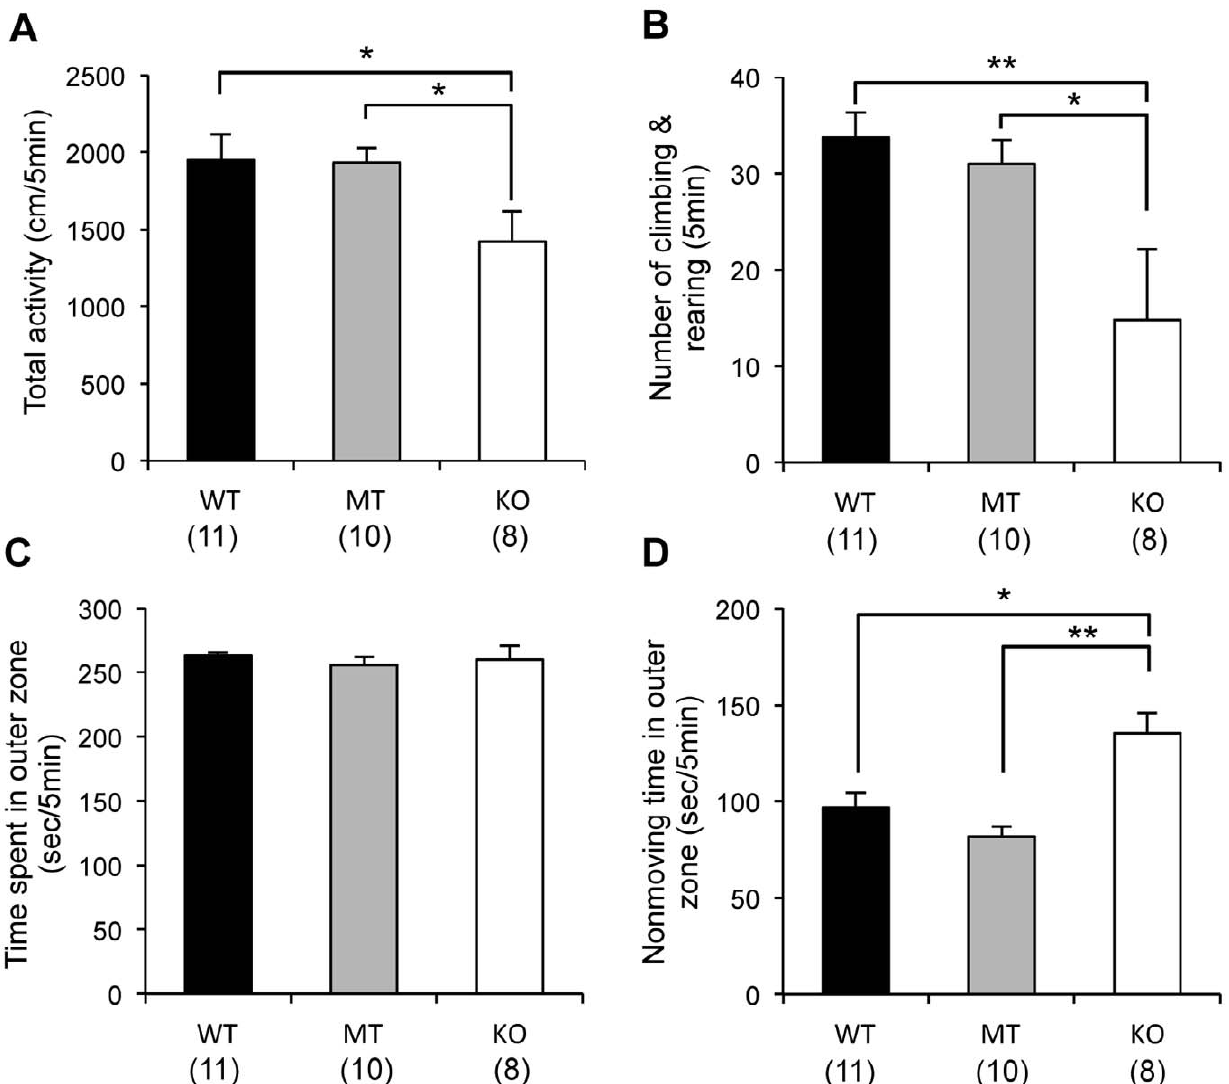
Figure 1. Open field test. Total distance of movement (A), number of climbing and rearing events (B), time spent in the outer zone (C), and resting time in the outer zone (D) of an open field for 5 min. Usp46 KO mice showed significantly lower values than WT and MT mice for the total distance of movement and the number of climbing and rearing events. Nonmoving time in the outer zone was significantly higher for KO mice. The number of mice used is shown within parentheses. One-way ANOVA with Fisher’s PLSD test; * P , 0.05, ** P , 0.01.